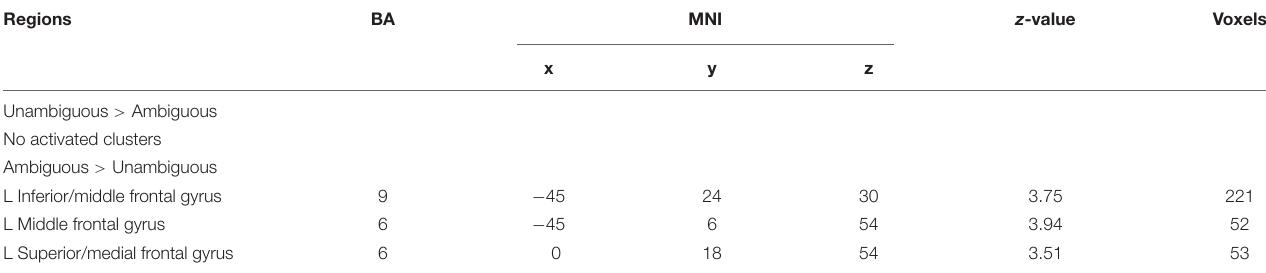
TABLE 3 | Main effect of preference.